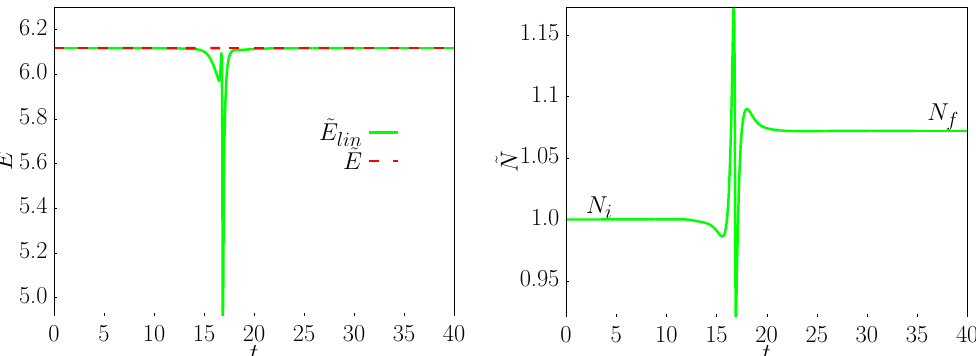
Figure 4 . Time evolution of the linearized and exact energy (left panel) as well as the instantaneous particle number (right panel) for the exemplary solution in (cid:12)gure